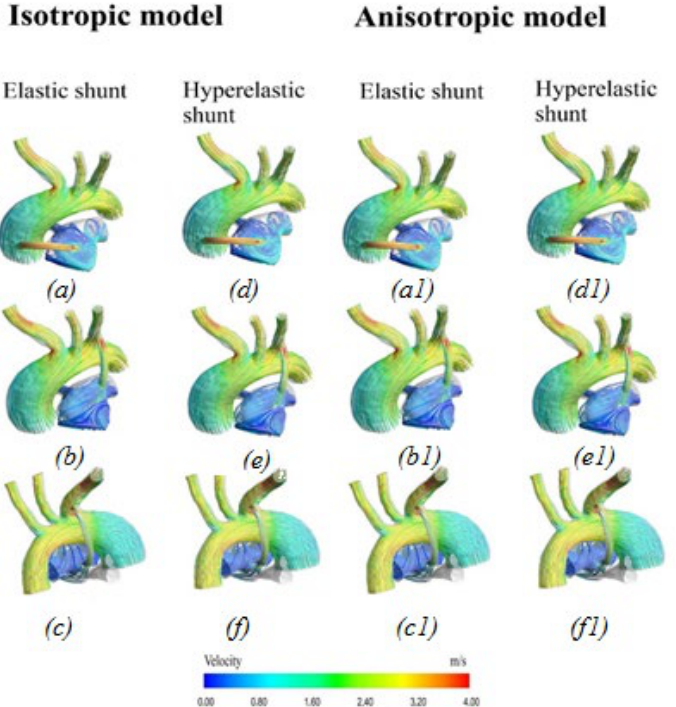
Figure 12. Velocity distribution: ( a , d , a1 , d1 ) central shunt; ( b , e , b1 , e1 ) right shunt; ( c , f , c1 , f1 ) left shunt.